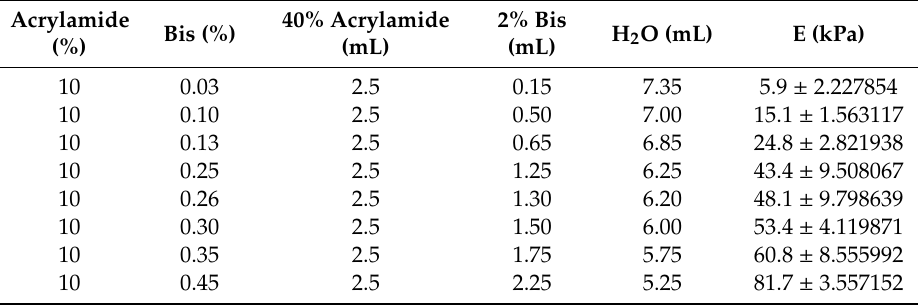
Table 1. Expected modulus of elasticity values after polymerization of relative acrylamide and bis-acrylamide